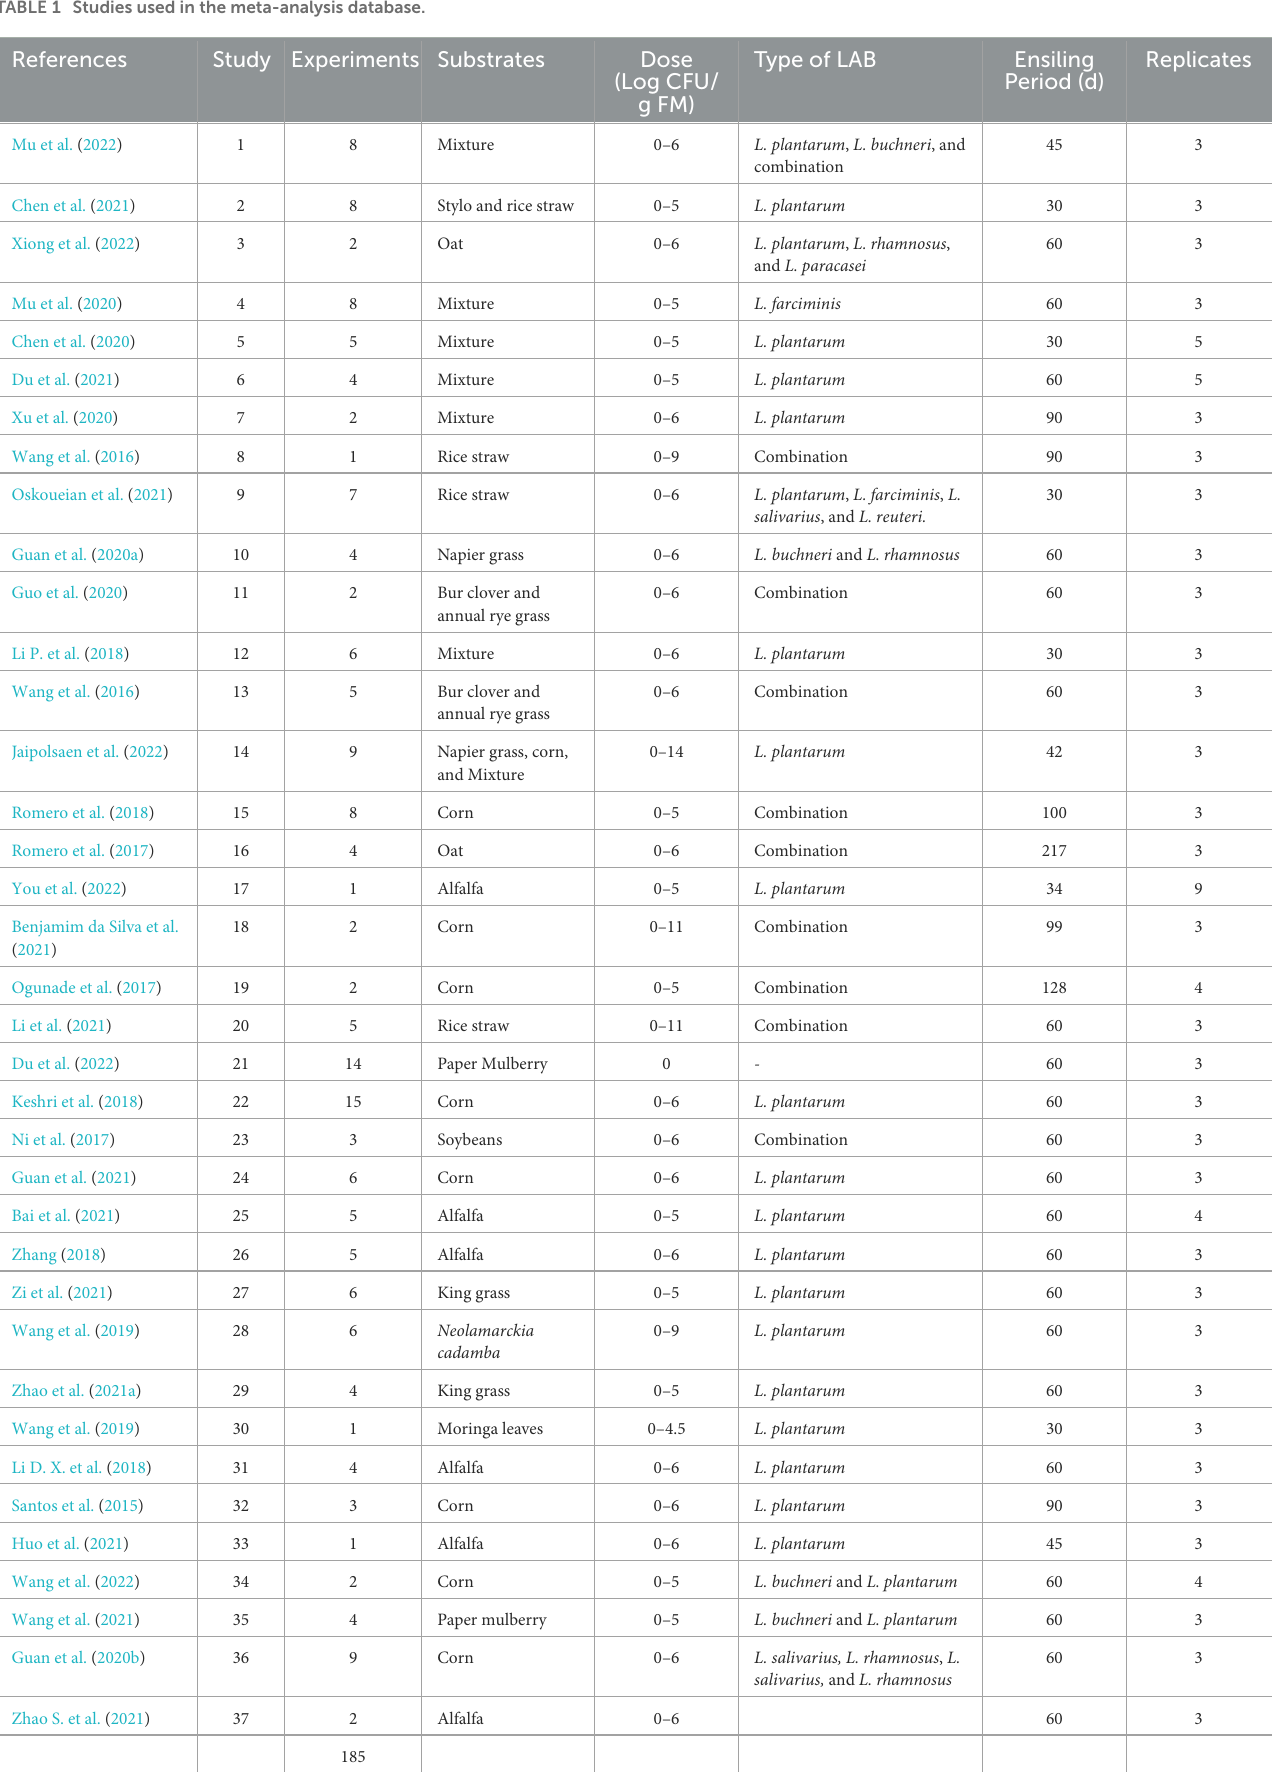
TABLE 1 Studies used in the meta-analysis